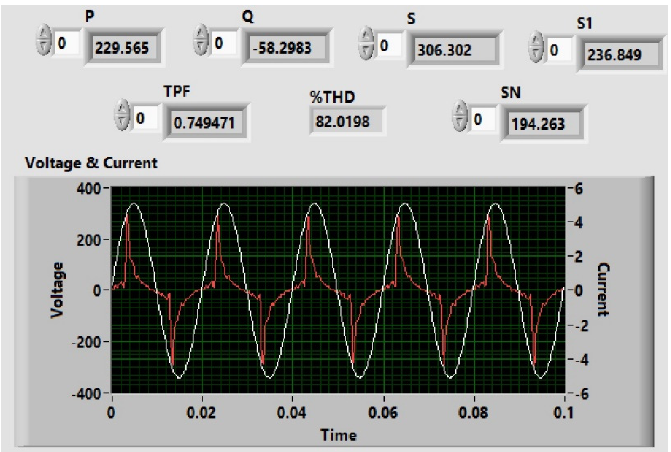
Figure 8. The voltage and current waveforms of the combination of the four real-world appliances: CFL + LED + exhaust fan + SMPS of a PC.